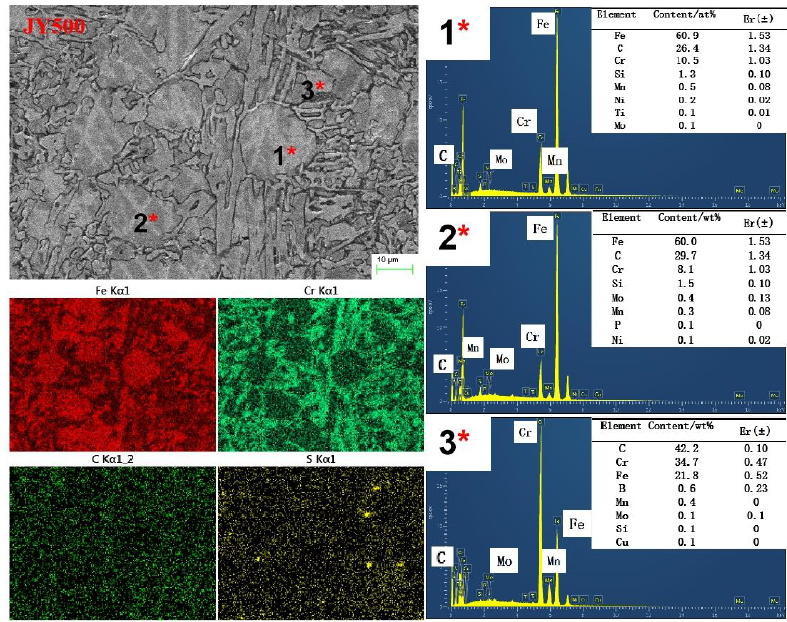
Figure 9. Microstructure and composition of subcritical quenching at 500 °C: EDS point analysis of point A; EDS area scans. The liquid-forged microstructure and the 500 °C subcritical-quenched microstructure were tested and analysed via X-ray diffraction, and the results are shown in Figure 10. The results obtained from XRD are consistent with the OM and SEM analysis results. The phase composition of the HCCI prepared at 128 MPa specific pressure includes the matrix composed of martensite and austenite, the primary and eutectic M 7 C 3 type carbides, some cementite and secondary cementite. However, after reaching the 500 °C subcritical quenching, the phase composition of the microstructure changes. First, the matrix mar- tensite increases, with a small amount of retained austenite, and the types of carbides also increase. In addition to the M 7 C 3 type carbides, there are also diffraction peaks character- istic of secondary precipitated carbides M 23 C 6 . After further testing, it was found that Fe 3 C, Fe 2 C, and other carbides are also present in the samples. （ a ）